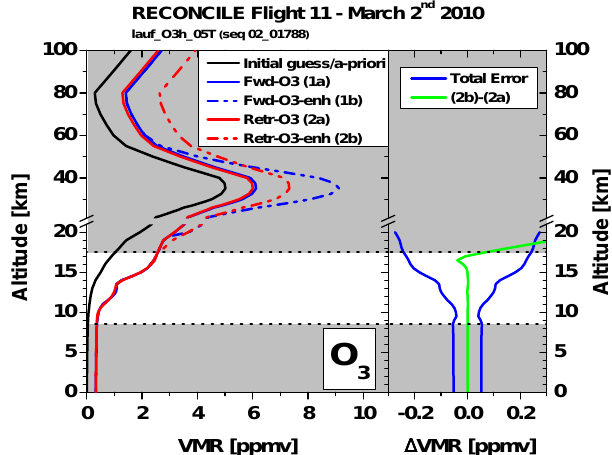
Fig. 11. Retrieval simulations for different ozone maxima above the flight path (flight altitude: 16.7km). Left panel: Profile Fwd-O3 (1a), derived from nominal processing of scan 02 01788, and Fwd- O3-enh (1b) with enhanced ozone above flight path were applied for forward calculations based on the viewing geometries, measure- ment noise and atmospheric conditions of scan 02 01788. The re- sulting forward spectra were retrieved again, yielding profiles Retr- O3 (2a) and Retr-O3-enh (2b). Right panel: Comparison of total error of nominal retrieval result and difference between (2b) and (2a). Regions with vertical resolution of the nominal retrieval result worse than 5km shaded in